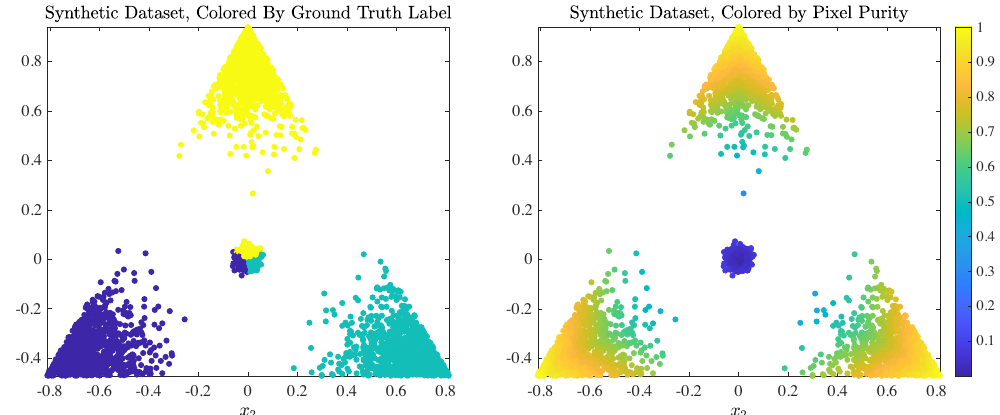
Figure 3. Ground truth labels and pixel purity of synthetic dataset sampled from a triangle in R 2 ; the K = 3 vertices of this triangle served as ground truth endmembers. Notice that empirical density maximizers near the origin are also the lowest-purity data